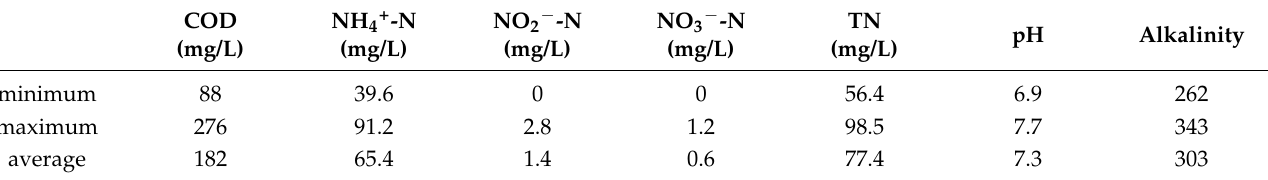
Table 1. The quality of real domestic wastewater.